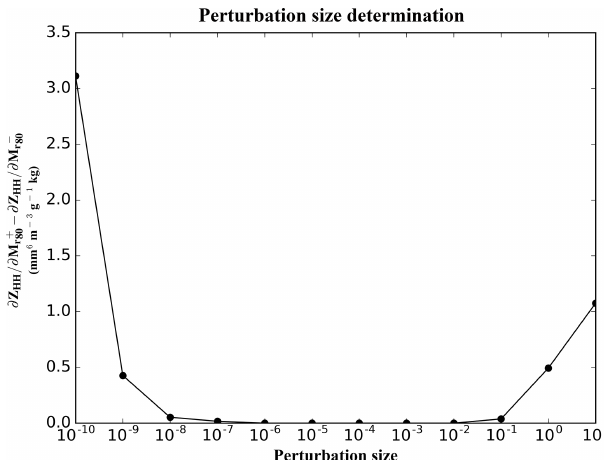
Figure 9. Difference between ∂Z HH /∂M r at model level 80 (about 1km of altitude), estimated with positive and negative perturbations as a function of the perturbation size δM r